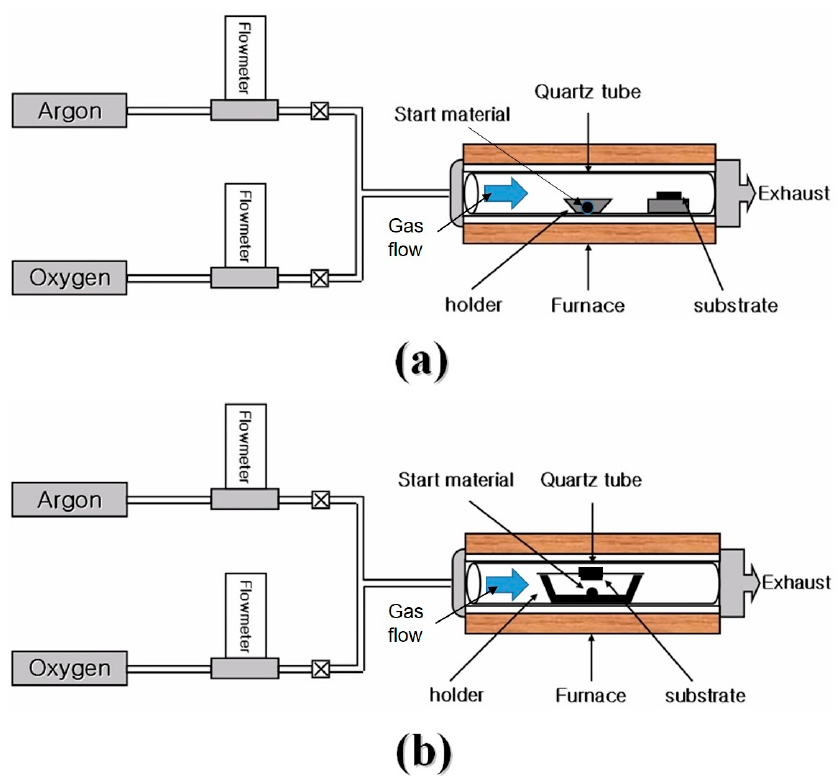
Figure 1. Schematics of thermal chemical-vapor deposition (CVD) setups in this study: ( a ) parallel and ( b ) perpendicular setups.